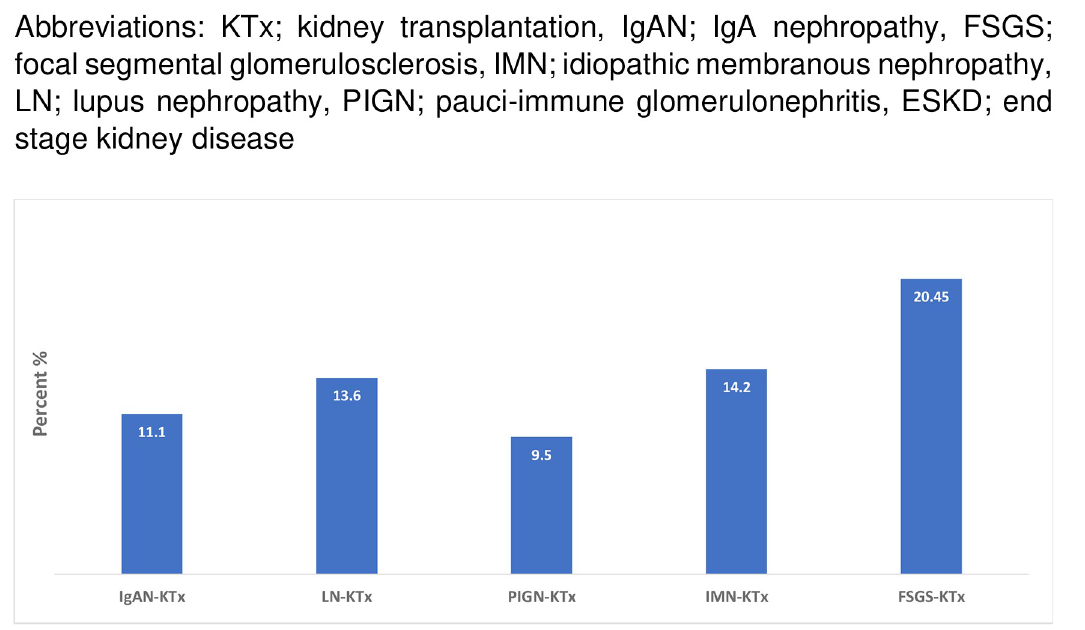
Fig 2. Frequency of primary disease recurrence in the graft among patients with glomerular diseases as cause of ESKD. the graft occurred in 5 (11.9%) out of 41 grafts from deceased donors, and in 18 (31.0%) grafts from living donors (p = 0.027). The mean human leukocyte antigen mismatch score in patients with recurrence was significantly lower, compared to those without recurrence (p = 0.002). The mean serum creatinine at recurrence was 2.1( ± 0.55) mg/dl, corresponding to an estimated glomerular filtration rate of 42.9( ± 14.4) ml/min/1.73m 2 , and a median 24-hour proteinuria of 262.5 mg (range: 120–1042). The majority of patients with recurrence were already treated with angiotensin-converting enzyme inhibitors or angiotensin receptor II blockers for arterial hypertension or were started soon after the diagnosis of recurrence. Two patients received immunosuppressive therapy for IgAN recurrence, including a 6-month course of oral